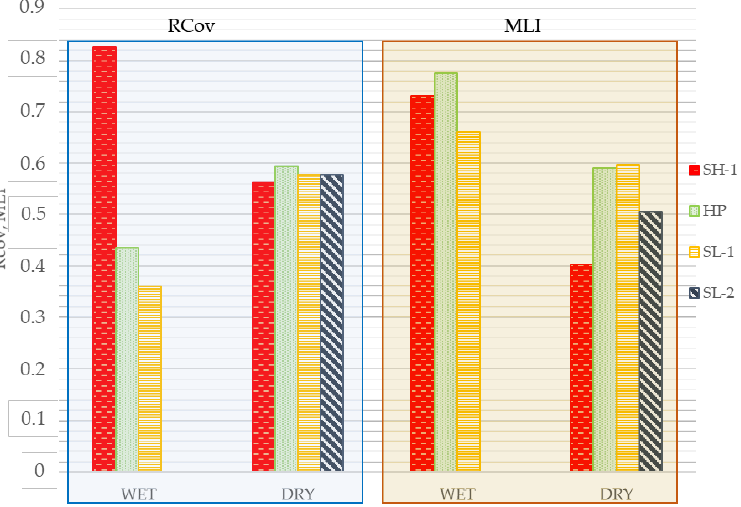
Figure 10. RCov and MLI for the samples under wet-snow and dry-snow conditions (average data).